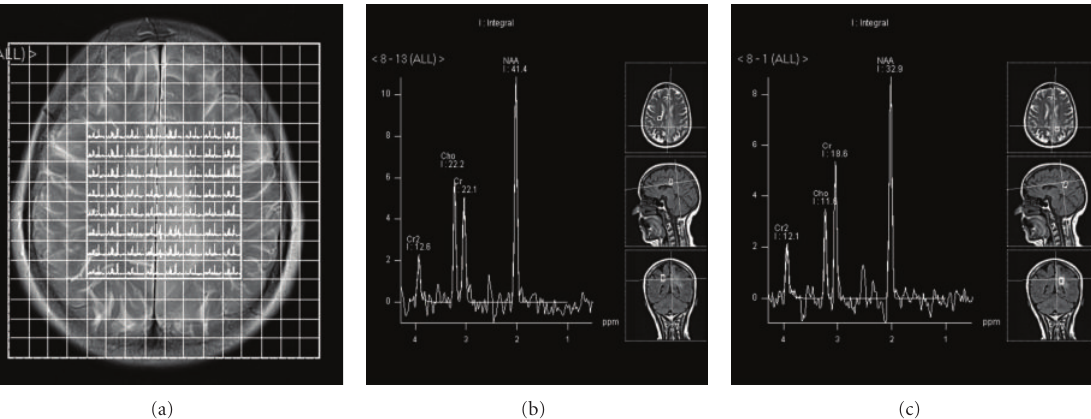
Figure 2: MRS CSI spectra (grid-2A) showing no alteration in metabolite ratios between normal (Figure 2(b)) and abnormal signal area of the brain (Figure 2(c)).